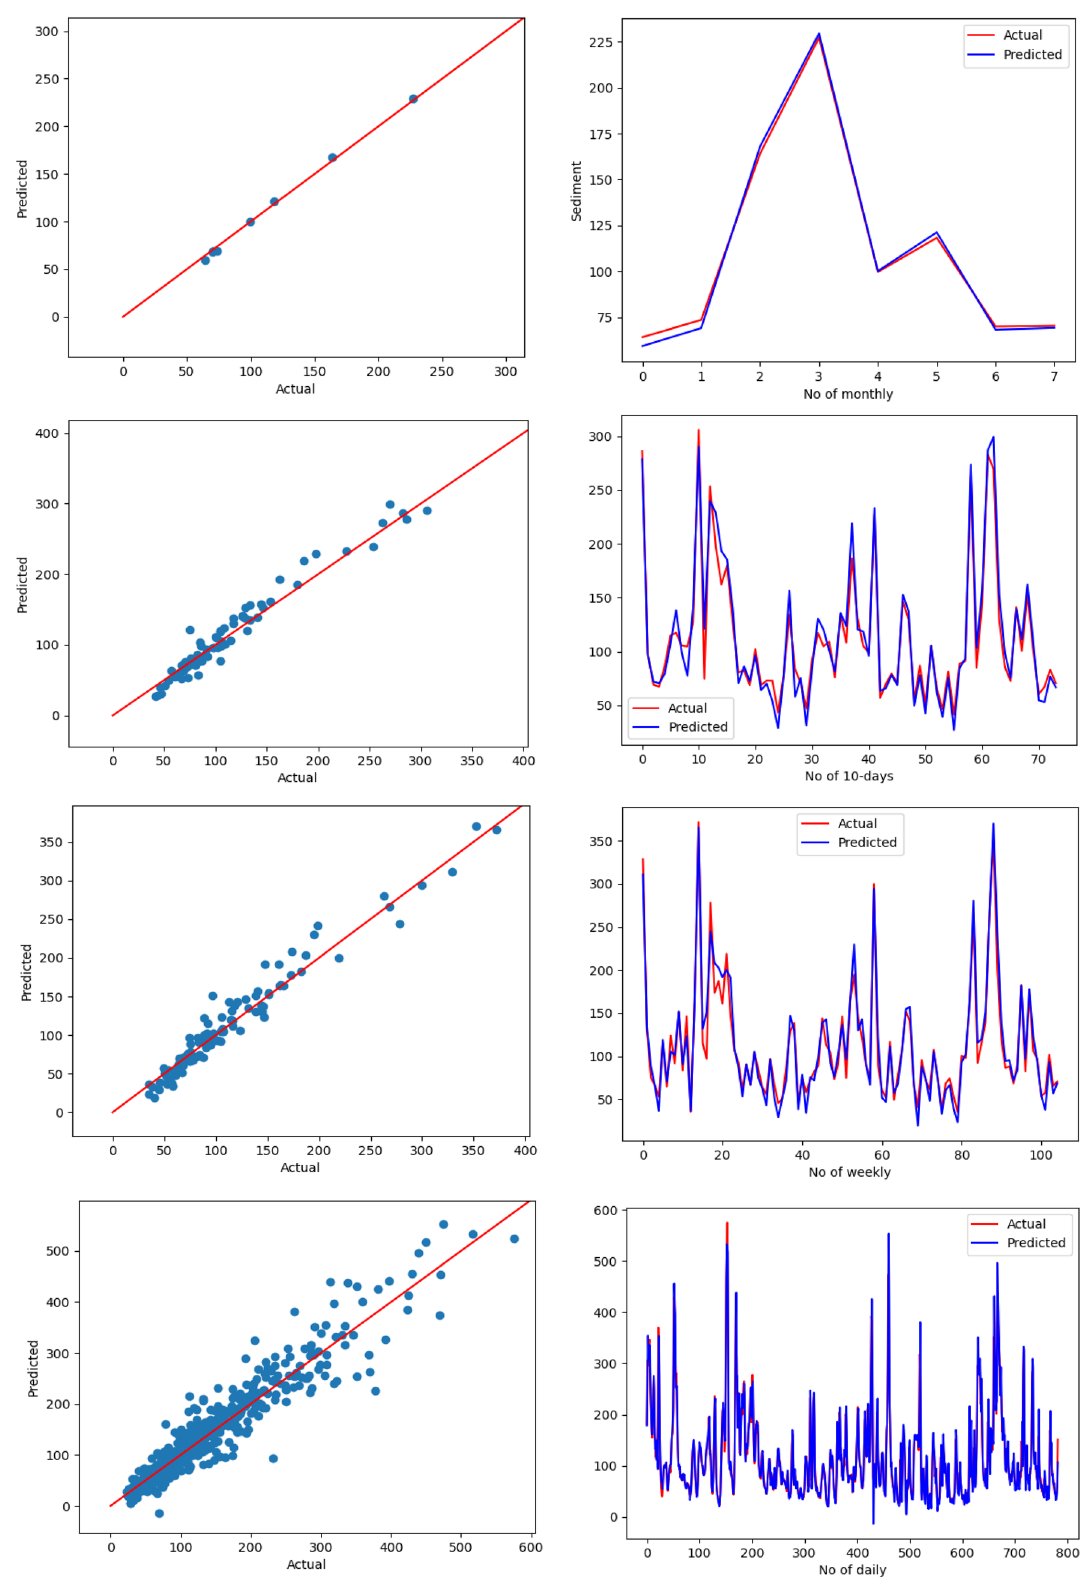
Figure 15. Scatter plot of actual sediment versus forecasted sediment for the proposed model for four scenarios: monthly (first row), 10 days (second row), weekly (third row), daily (fourth